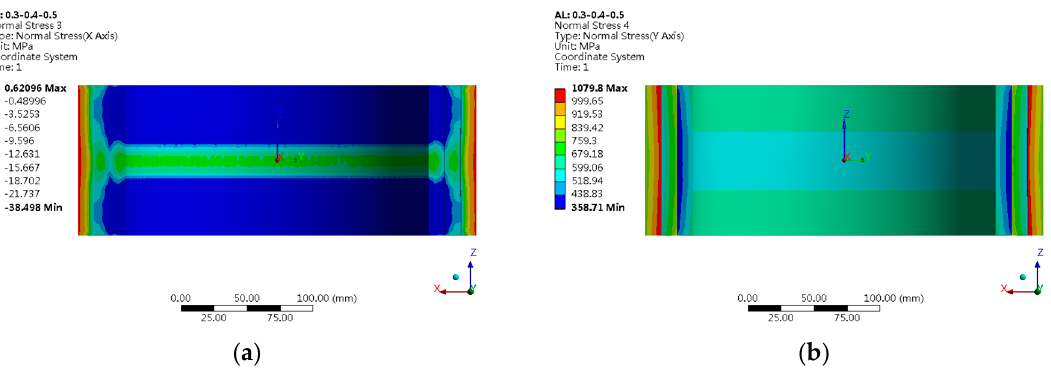
Figure 14. Flywheel rotor stress nephogram at maximum speed. ( a ) Radial stress cloud diagram of flywheel rotor; ( b ) Hoop stress cloud diagram of flywheel rotor.